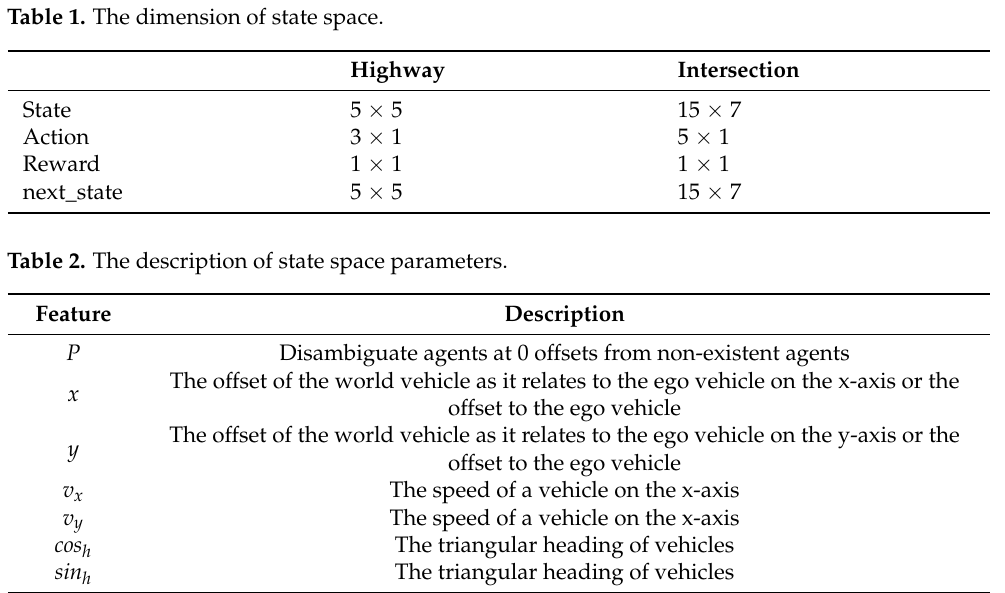
The triangular heading of